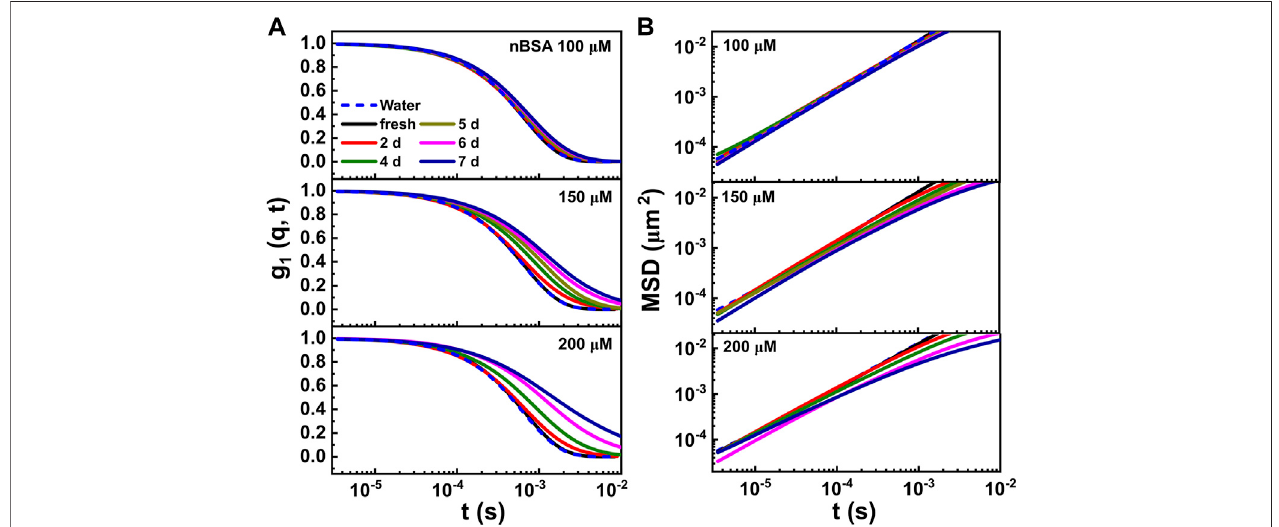
FIGURE 4 | (A) Time-dependent intensity autocorrelation curves, measured for the 100, 150 and 200 μ M nBSA solutions under the same aggregation conditions mentioned before, containing 0.03 vol/vol% 230 nm PEG-coated polystyrene latex tracer particles. The curves were measured starting from fresh solutions (presented as black curves) up to samples heated at 65 ° C for 7 days (navy blue curves). (B) Corresponding MSD data. For comparison, we present calculated MSD curves for the same 230 nm colloids in pure water (blue dashed lines).